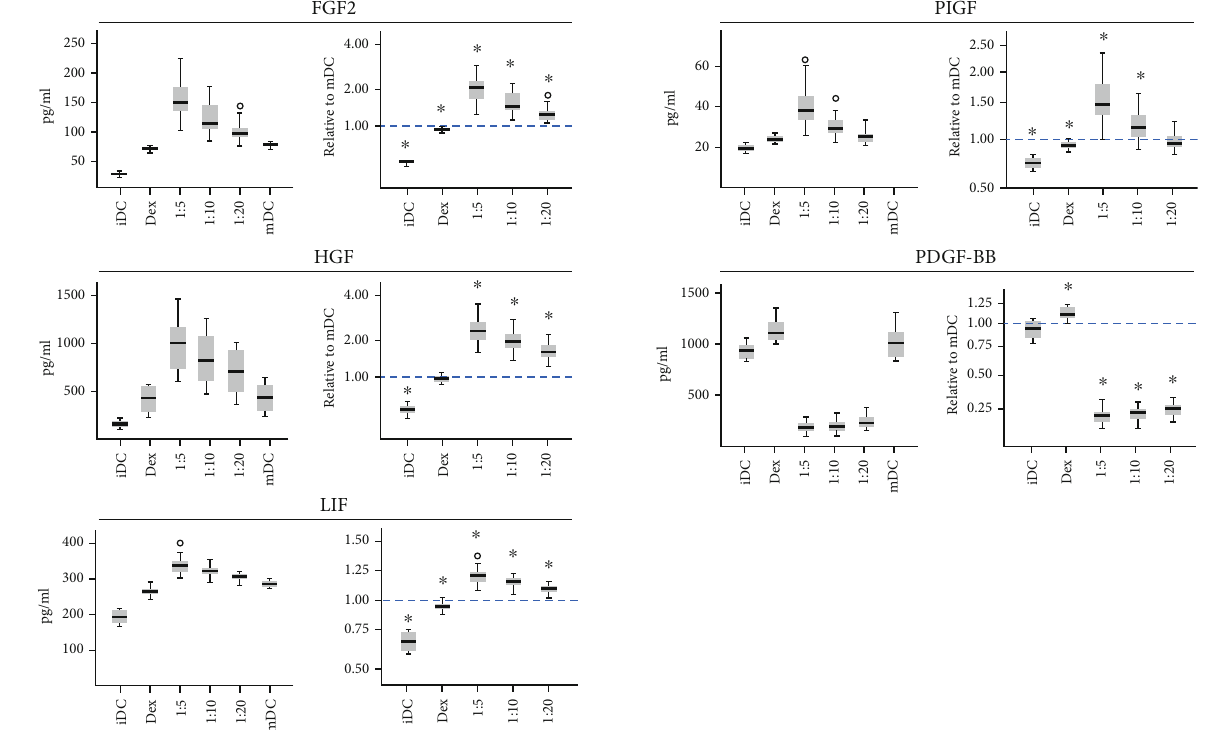
Figure 5: Absolute and relative concentrations of FGF2, HGF, LIF, PlGF, and PDGF-BB. 1 :5-1 :20 refer to ratios of ASC : DC. iDC: immature dendritic cell; Dex: dexamethasone control; mDC: mature dendritic cell; ASC: adipose tissue-derived stromal cell. Signi fi cant di ff erences from mDC (adjusted p ≤ 0 : 05 ) marked with an asterisk ( ∗ ). n = 20 , resulting from 5 ASC donors and 4 DC